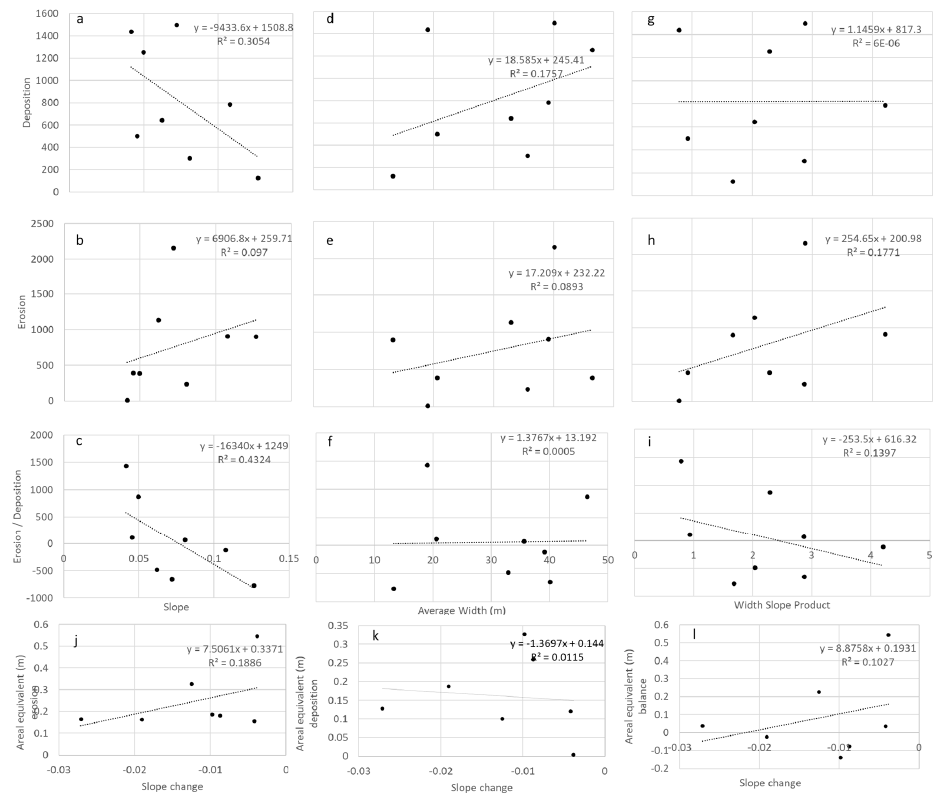
Figure 7. Slope and channel constriction, erosion and deposition recorded along Liza Beck between 2009 and 2017 .